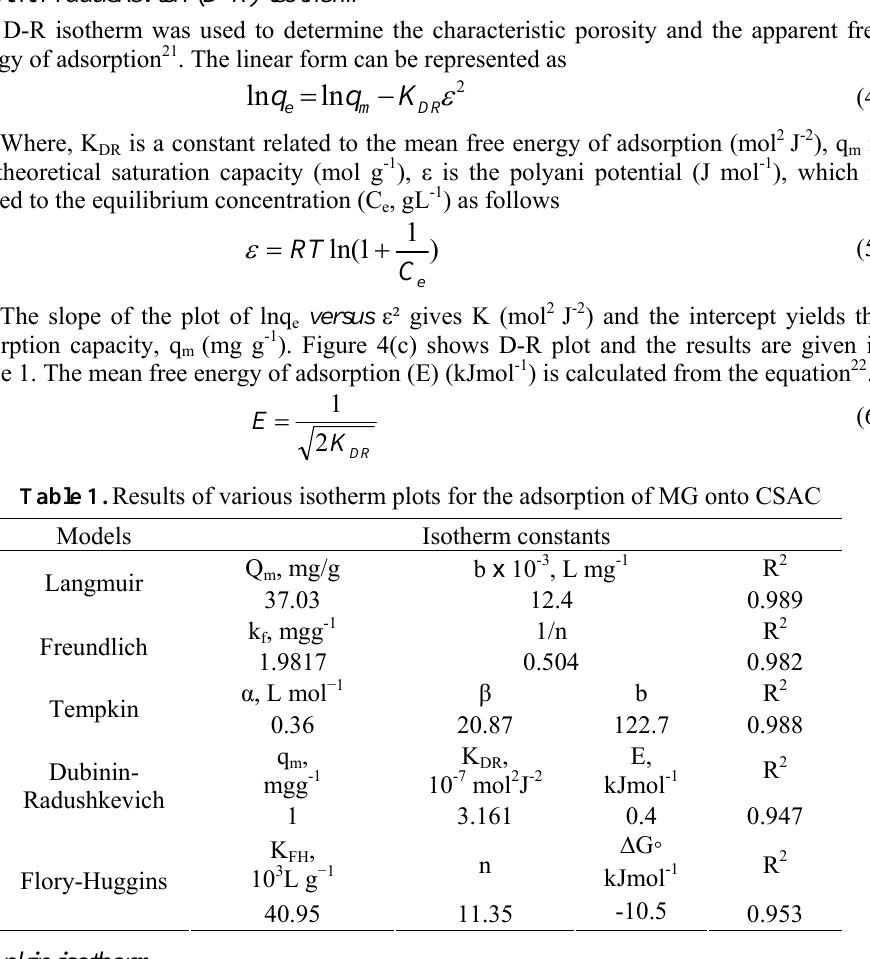
Table 1. The mean free energy of adsorption (E) (kJmol -1 ) is calculated from the equation 22 .